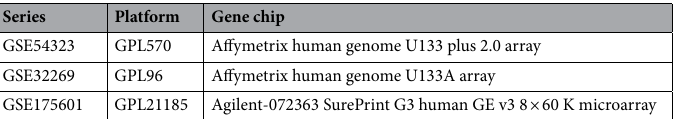
Table 1. Information on the Selected GEO